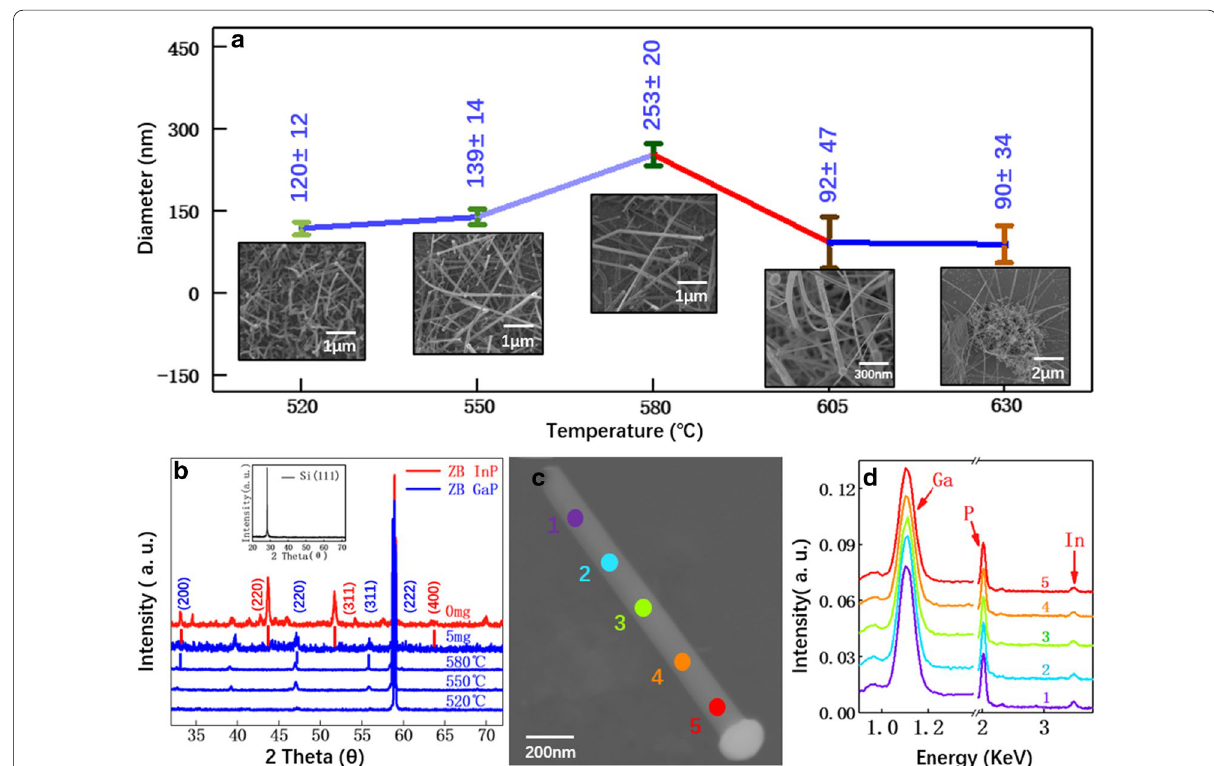
Fig. 3 Synthesis of InGaP nanowires. a Diameter distribution of InGaP nanowires at different growth temperatures (550–630 °C) with embedded characteristic SEM images. b XRD spectra of InP (red curve) and InGaP (blue curves) nanowires at different growth conditions. XRD spectrum of Si(111) substrate is shown in the inset as a reference. SEM ( c ) and the corresponding EDS spectra ( d ) of a InGaP nanowire grown at 550 °C. The gallium powder weight is 3.0